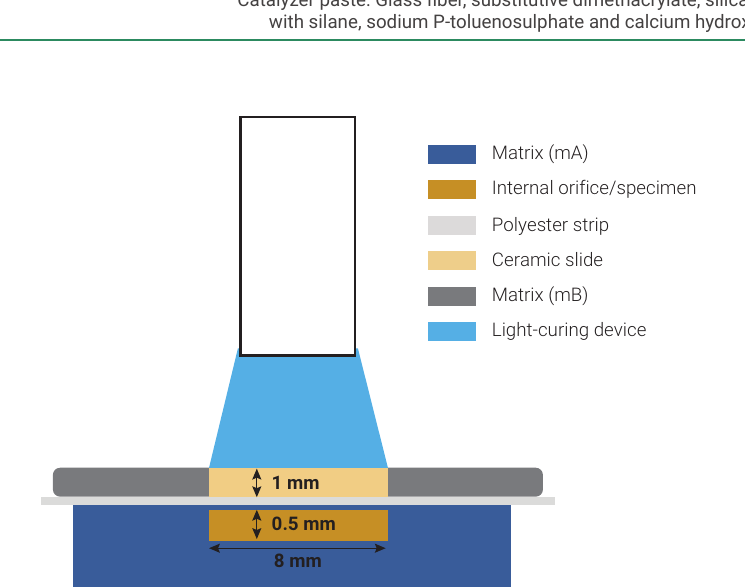
Figure 2. Illustrative diagram of test specimen fabrication.